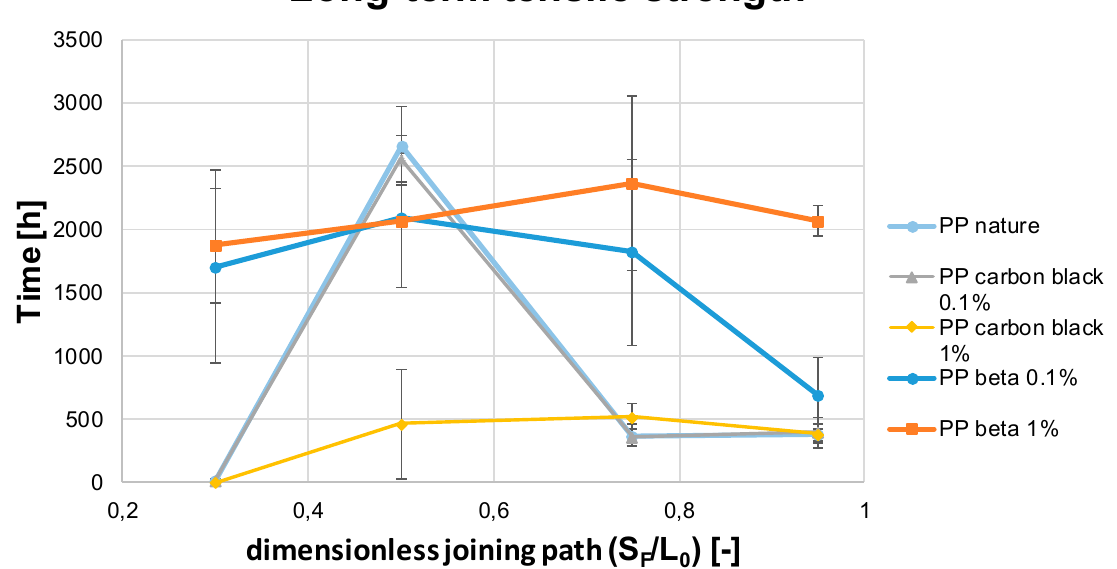
Figure 11. Long-term tensile strength of the welded PP samples for different dimensionless joining paths.